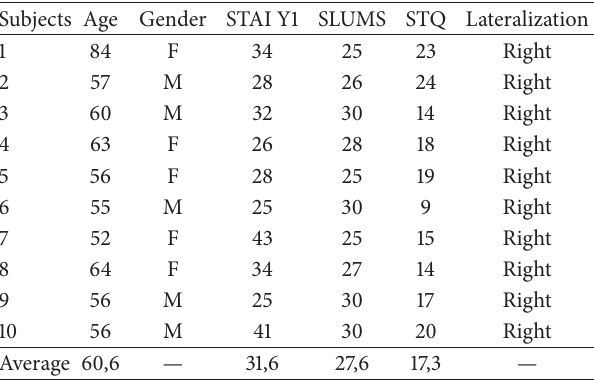
Table 1: Subjects